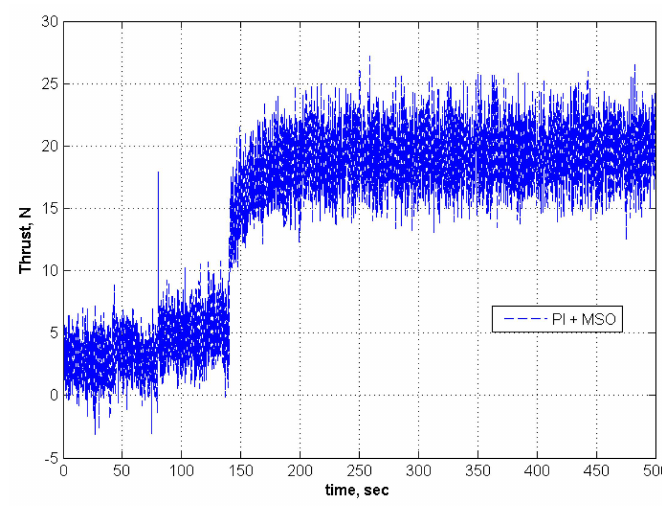
Figure 17. Thrust response for 50% C m α in an